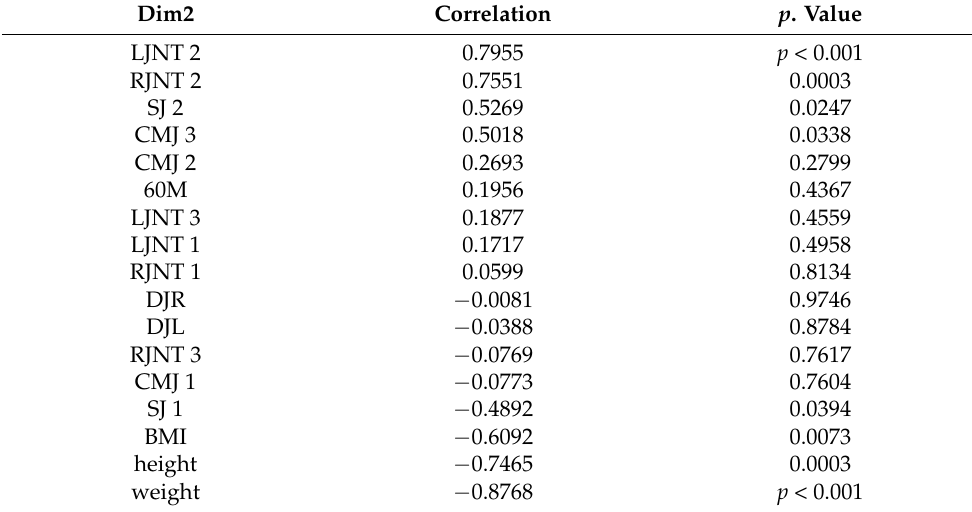
Table 2. Indicators significantly correlated to